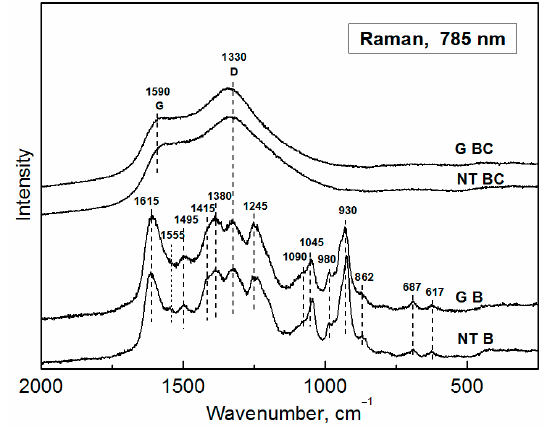
Figure 5. Raman spectra of original globular (G) polypyrrole bases and polypyrrole nanotubes (NT) before (B) and after carbonization (BC). before (B) and after carbonization